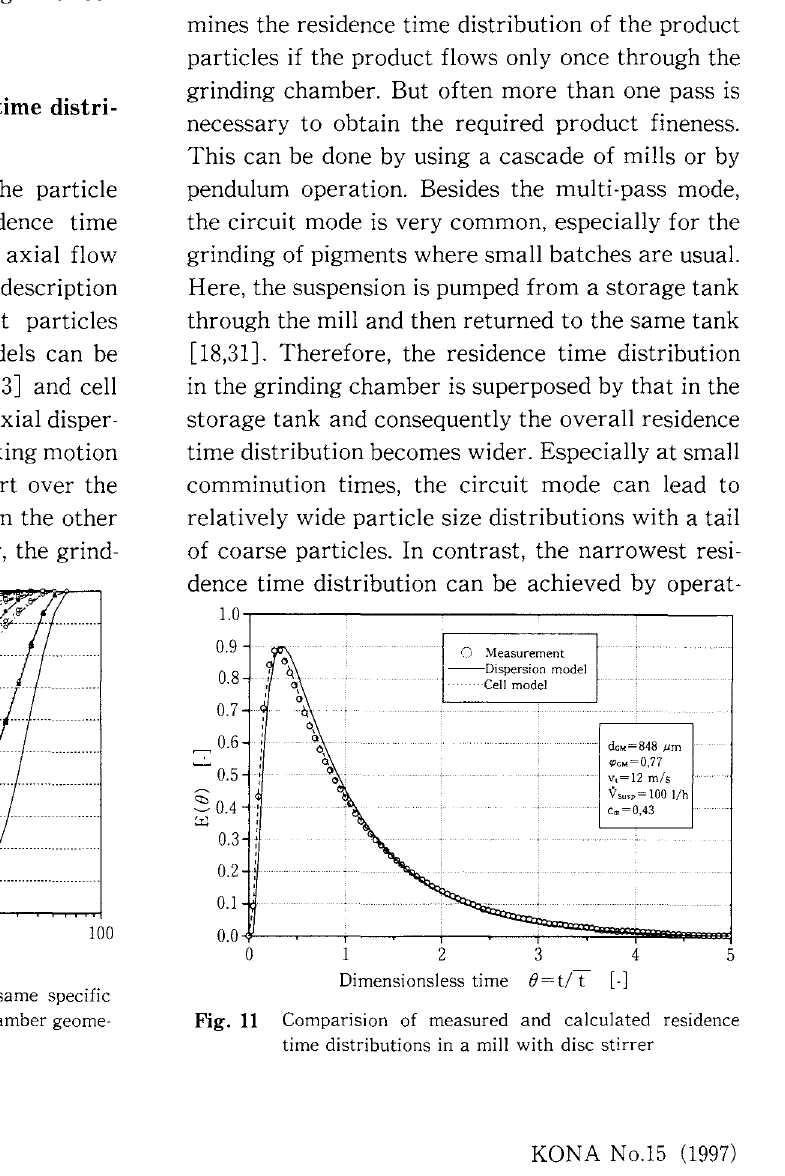
Fig. 10 Comparison of grinding results at the same specific energy input; three different grinding chamber geome Fig. 11 Comparision of measured and calculated residence time distributions in a mill with disc